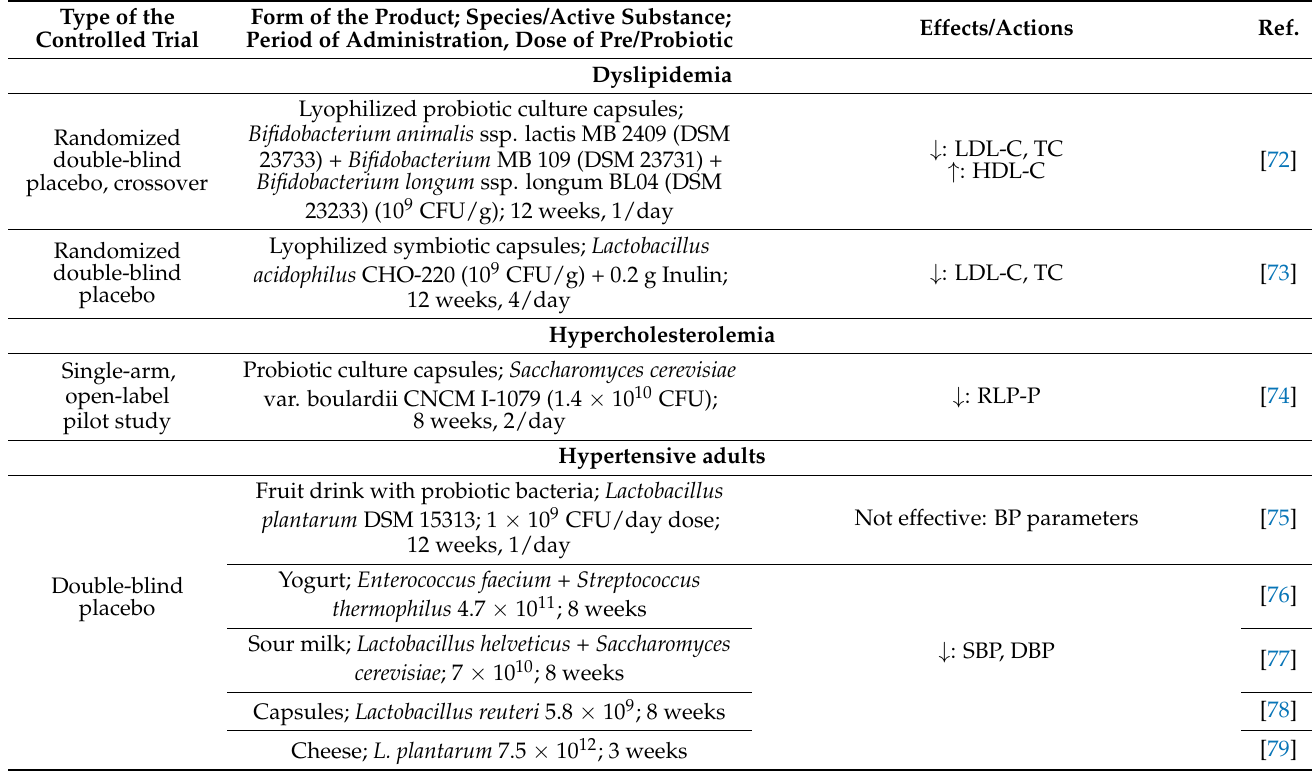
Table 1. Summarizing the published data related to the clinical trials considering the effects of pre-/probiotics on the associated risk factors to MetS